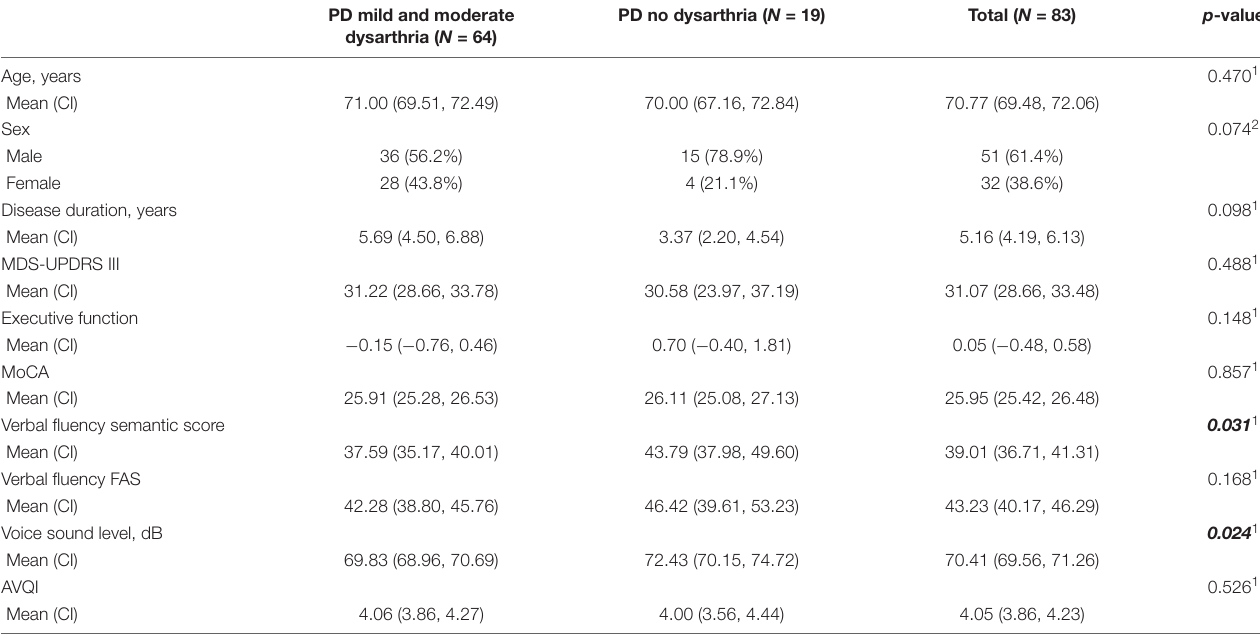
TABLE 2 | Variables used for neuroimaging comparisons stratified into PD with and without dysarthria. PD mild and moderate dysarthria ( N =